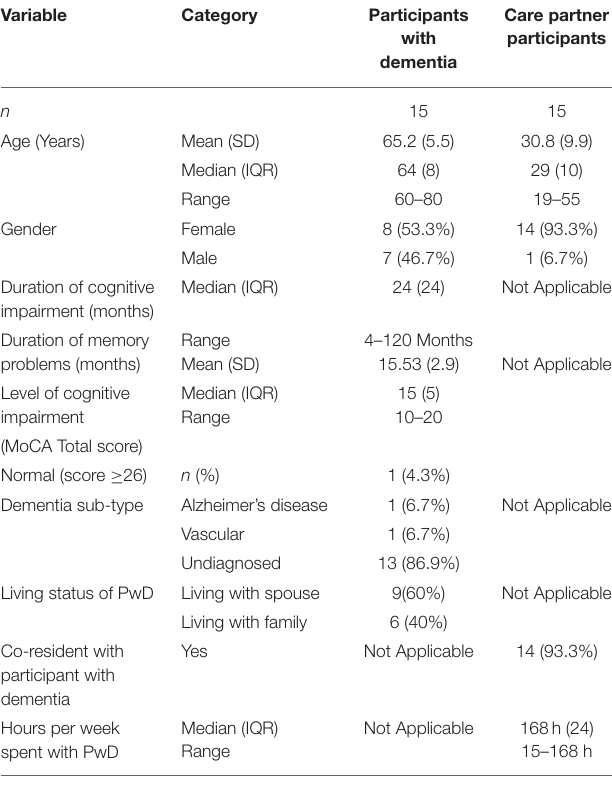
TABLE 2 | Summary of participant inclusion and exclusion criteria and characteristics. Inclusion